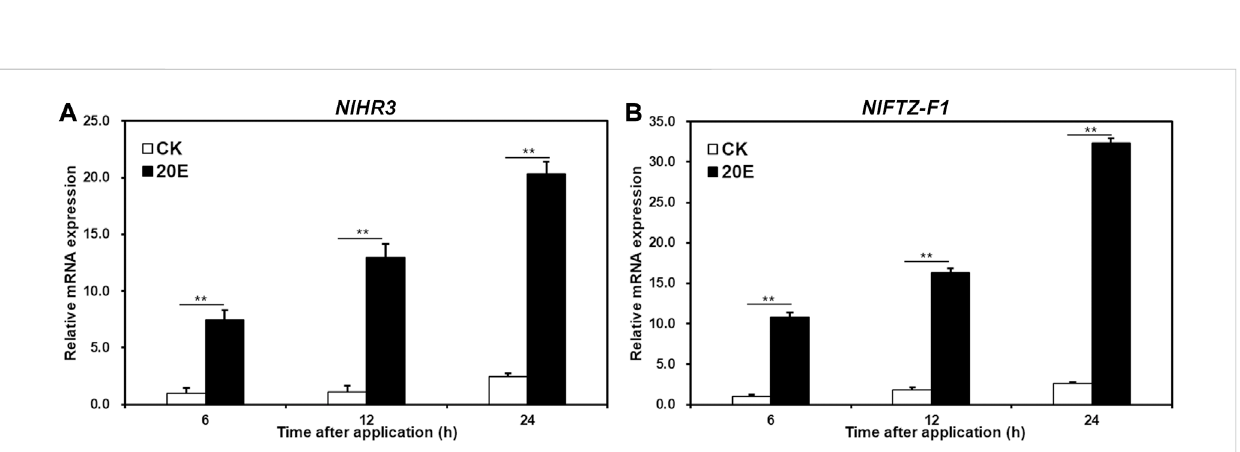
FIGURE 2 Transcriptional responses of NlHR3 and NlFTZ-F1 to the 20E signaling pathway. (A) Effect of 20E on the expression of NlHR3 . (B) Effect of ecdysone on the expression of NlHR3 . SE was determined from three independent biological replicates, each with three technical replications. ** indicates a signi fi cant difference at a p -value < 0.01 (Student ’ s t